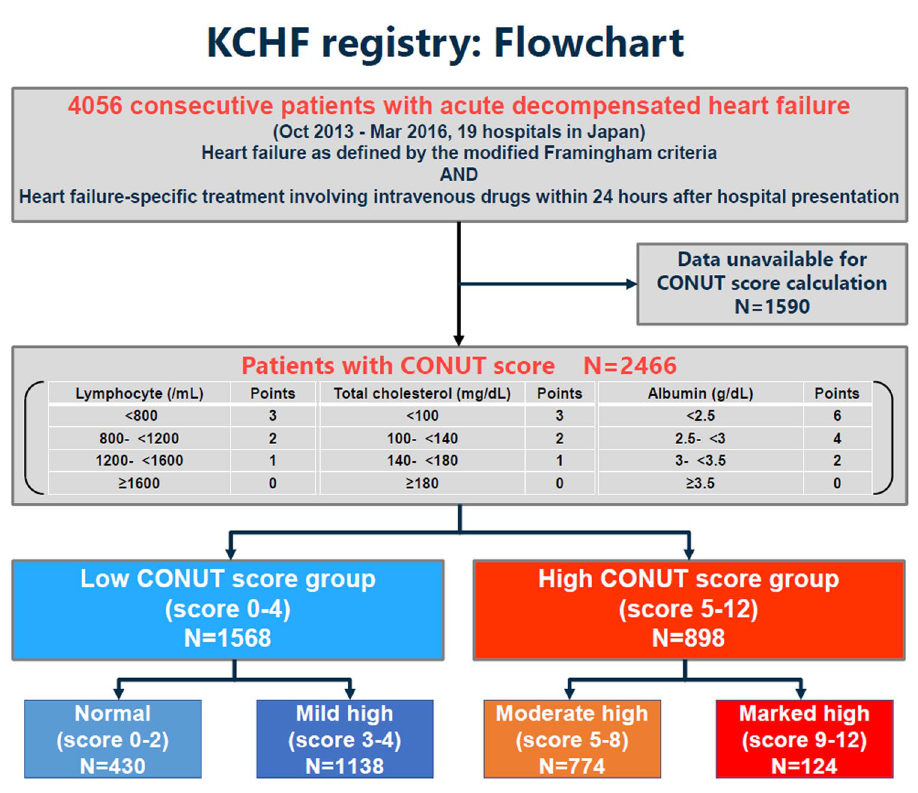
Figure 1. Patient flowchart. KCHF = Kyoto Congestive Heart Failure, CONUT = Controlling Nutritional